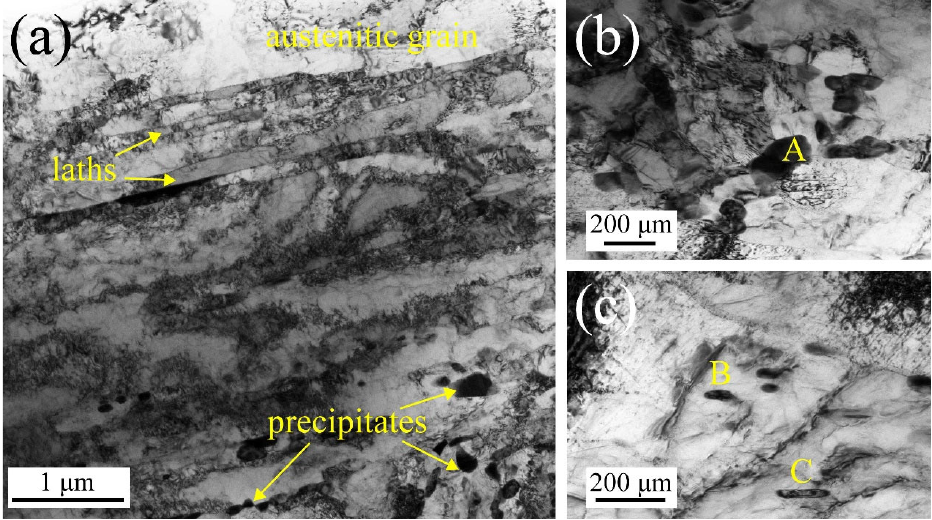
Figure 2. TEM image of the as ‐ received MarBN steel: ( a ) martensite laths with high dislocation density; ( b , c ) different types of precipitates. Table 2. Detailed chemical compositions of different types of precipitates (wt.%).